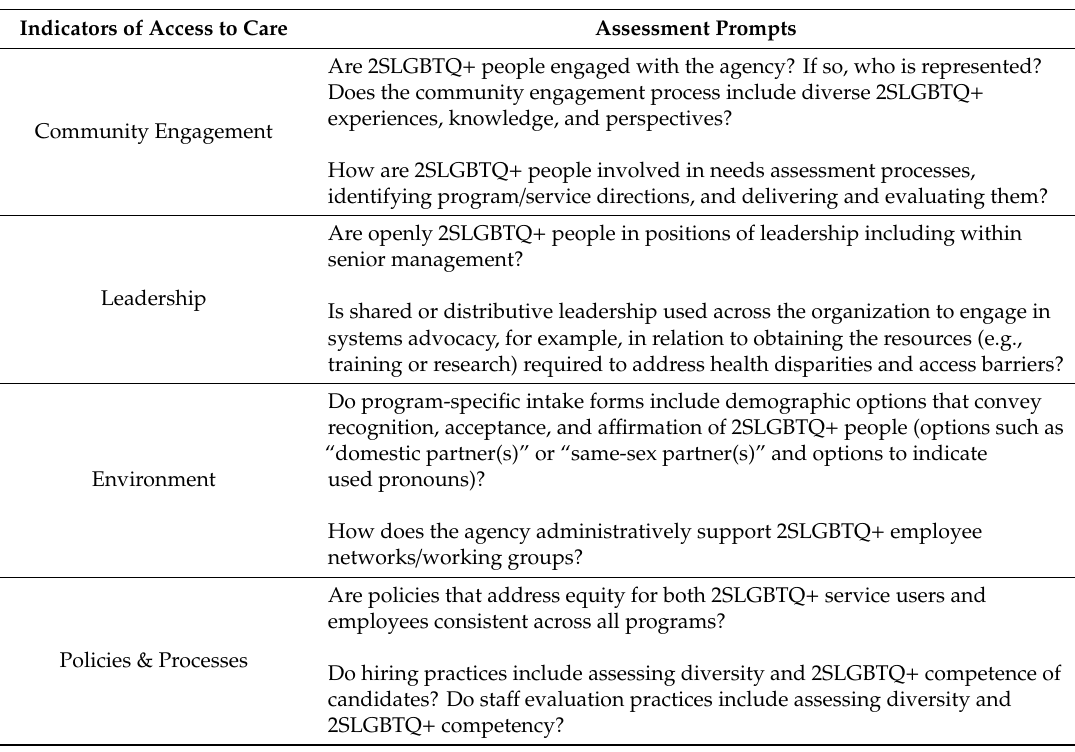
Table 2. Assessing 2SLGBTQ +